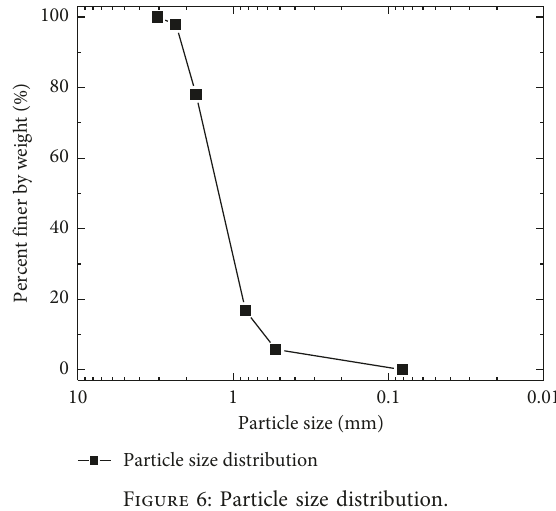
Figure 6: Particle size distribution.